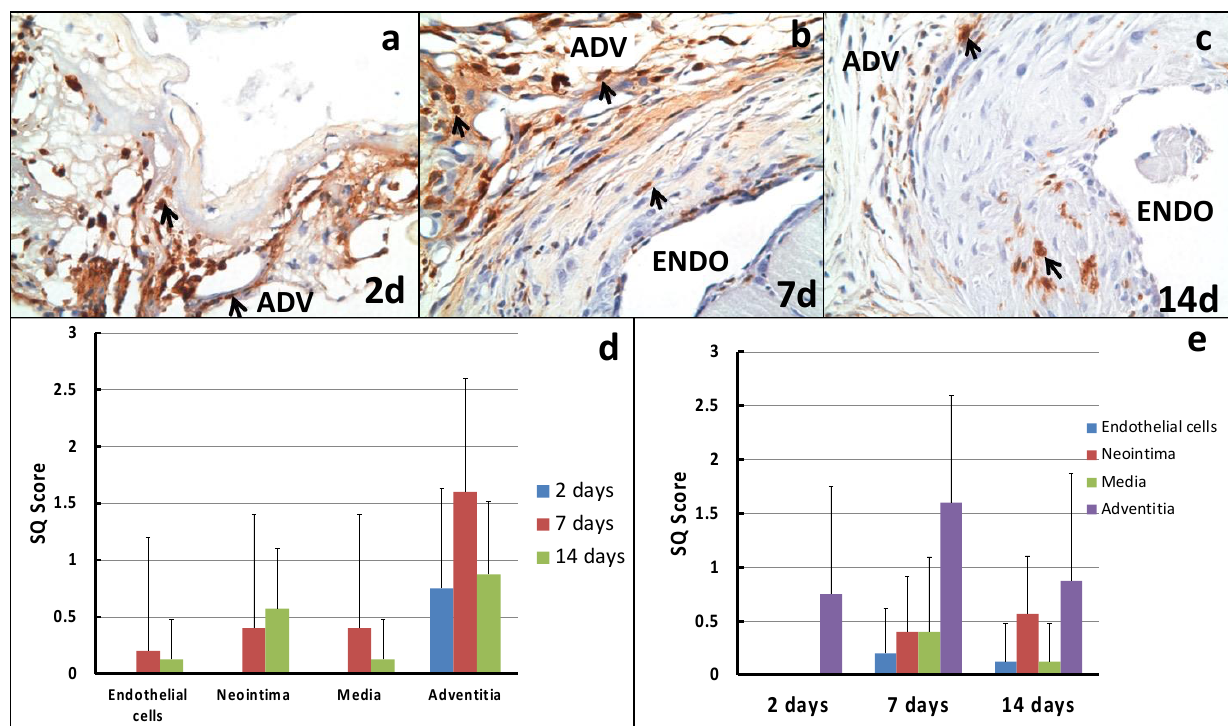
Figure 4. Macrophage infiltration in the mouse AVF stenosis model: ( a – c ) show the immunohistochemistry for Mac-2 at 2 d, 7 d and 14 d, respectively. Note the early (2 d adventitia) and persistent (7 d and 14 d) presence of macrophage infiltration in our mouse AVF stenosis model, which is predominantly located in the adventitia but also increases in the neointimal region by 14 d. ( d , e ) show our semi-quantitative scoring system for Mac-2 across different timepoints and different regions of the AV anastomosis. Small black arrows indicate macrophages; Endo = luminal side; Adv = adventitial side.